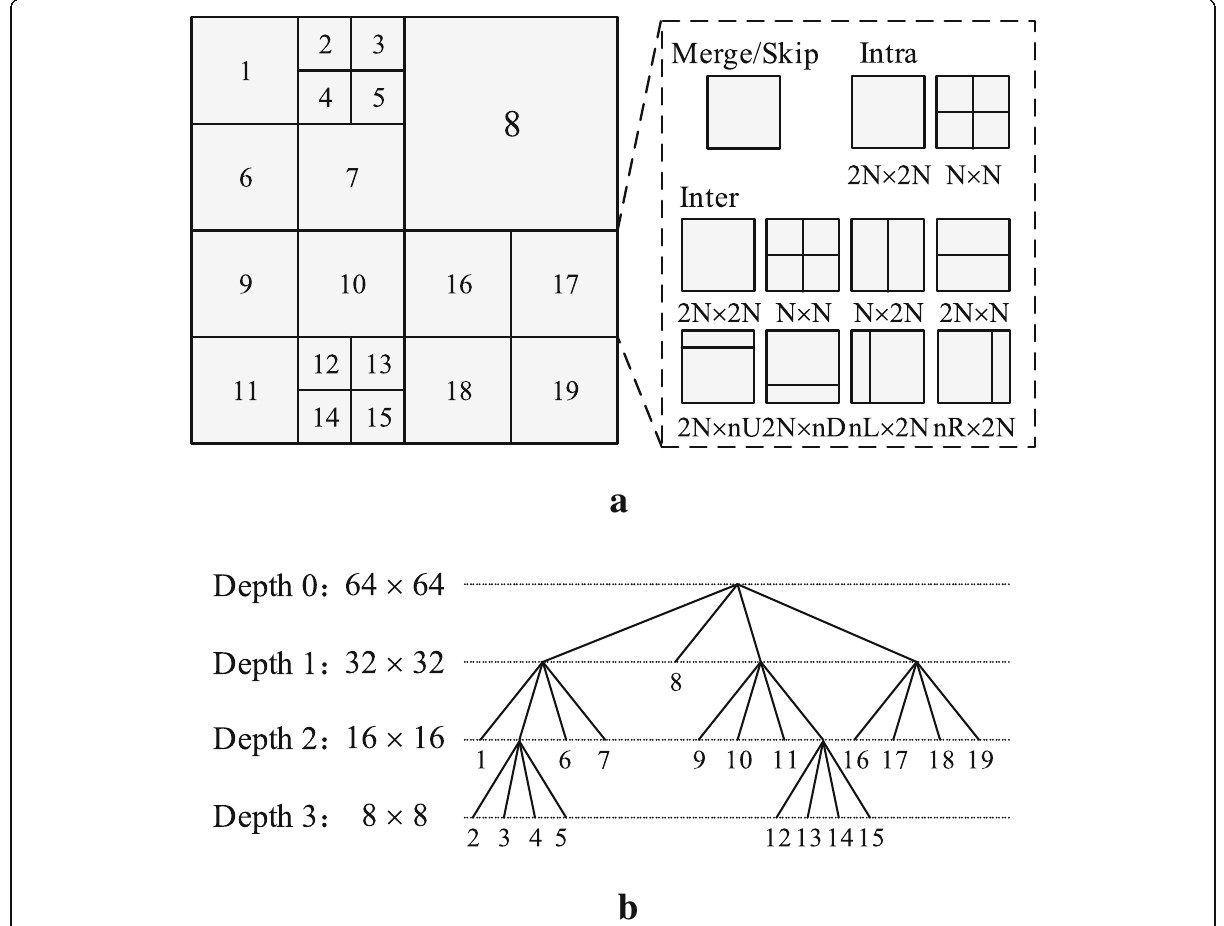
Fig. 1 Partition example of 64×64 CTU. a Example of CTU optimal partition and possible PU splitting mode for a CU. b Corresponding quad-tree